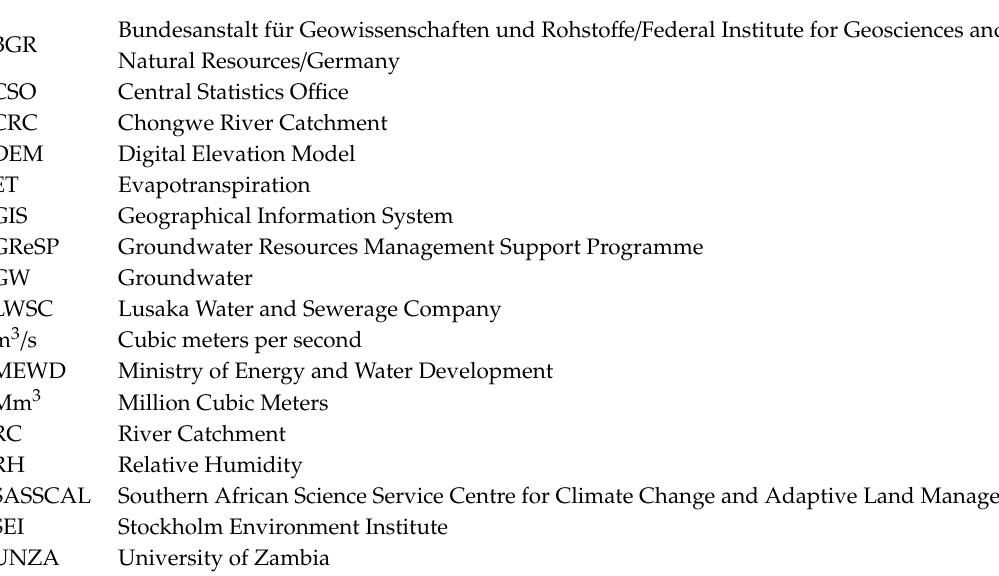
Figure S1: WEAP Model Years and Time Steps, Table S1: Computation of Nash-Sutcli ff e model e ffi ciency coe ffi cient